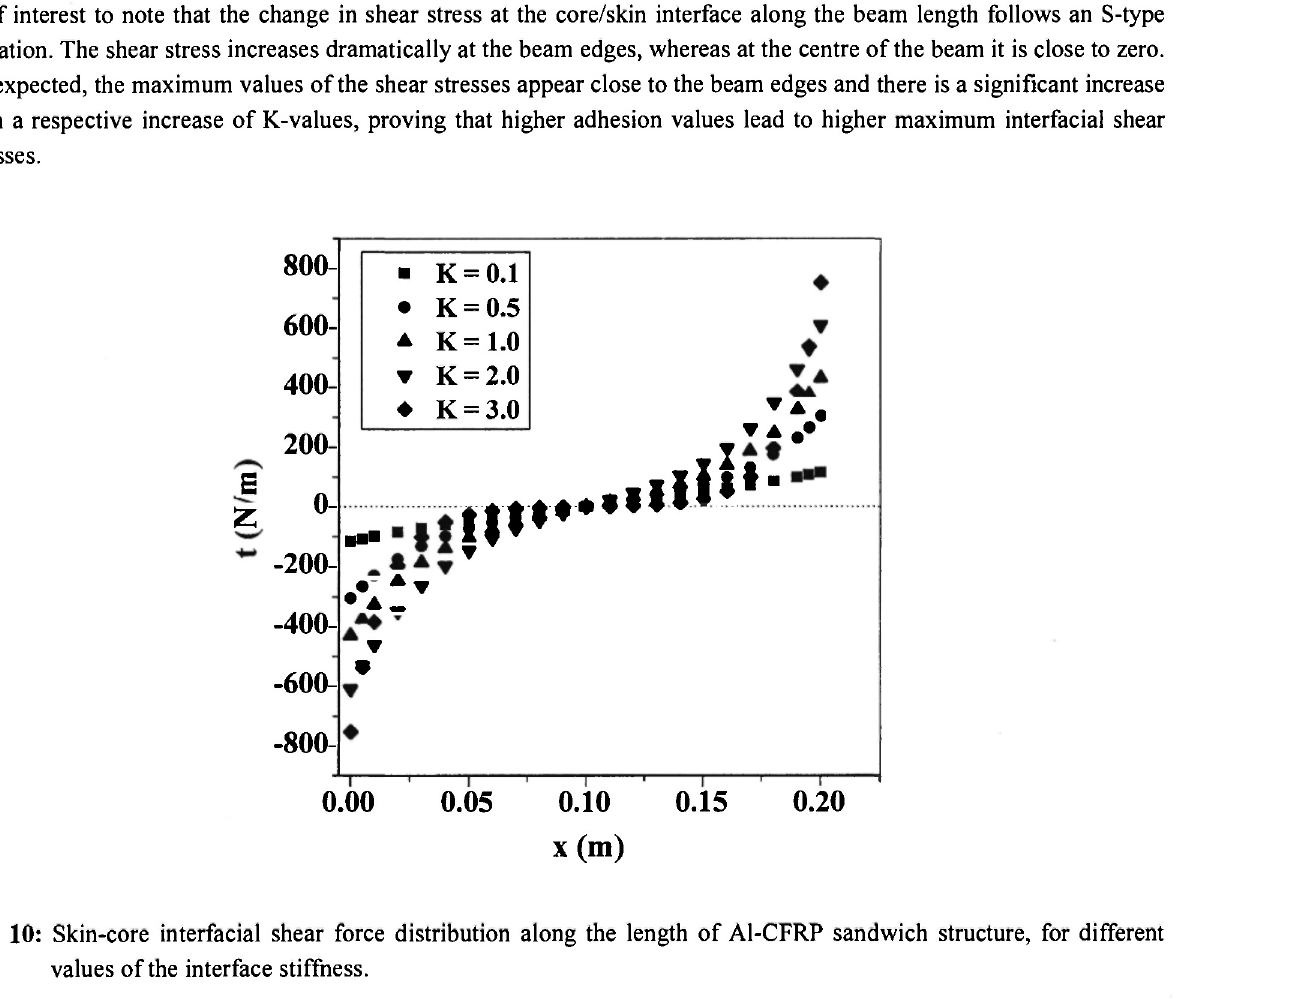
Fig. 10: Skin-core interfacial shear force distribution along the length of Al-CFRP sandwich structure, for different values of the interface